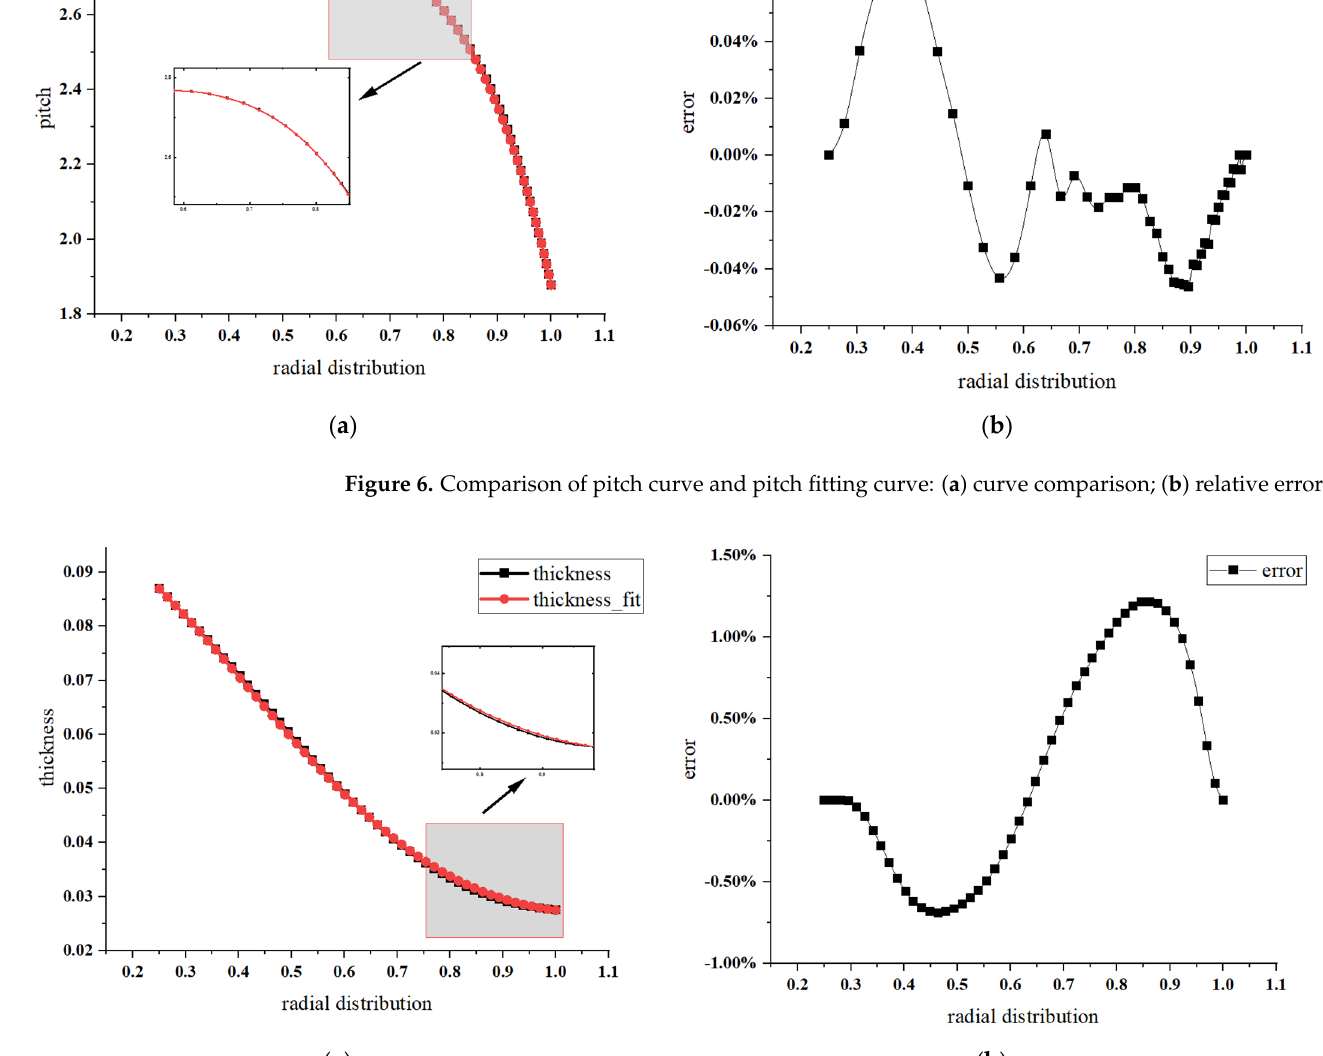
Figure 7. Comparison of thickness curve and thickness fitting curve: ( a ) curve comparison; ( b ) relative error.